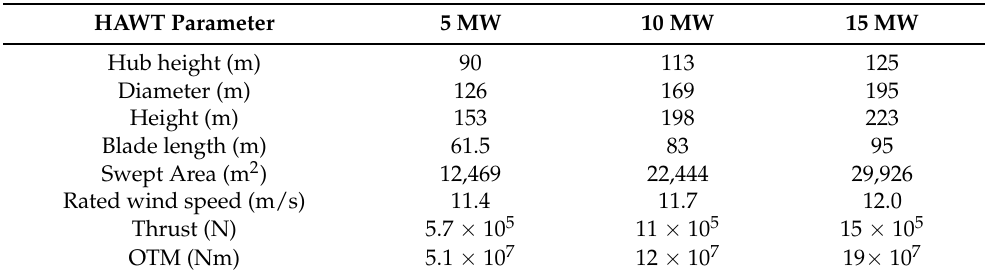
Table A1. HAWT turbine specifications.